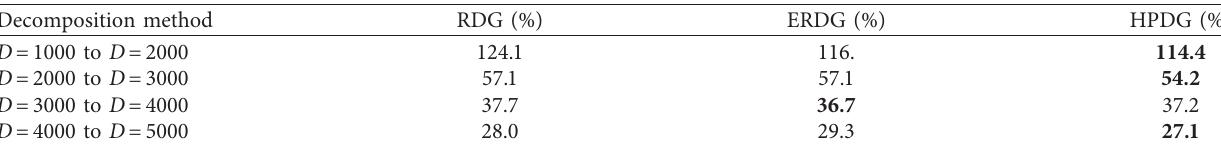
Table 10: The average growth rates of FEs of f 1, f 2, f 4, f 5, f 7, f 10, f 12, f 13, f 14, f 15, f 16, f 17, f 18, f 19, and f 20 on CEC’2010 special sessions on large-scale global optimization. The best growth rates of FEs are shown in bold font.